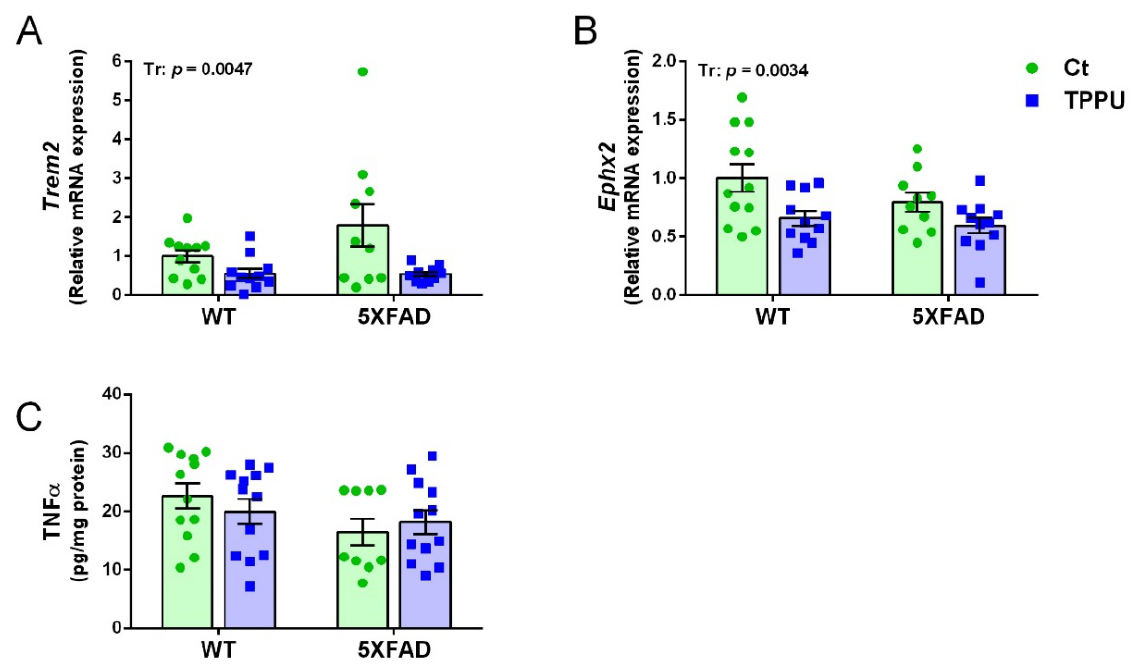
Figure 6. Neuroinflammatory markers in 2-month-old 5XFAD mice from litters with maternal TPPU treatment or control (Ct). Expression levels of the genes Trem2 ( A ) and Ephx2 ( B ); ( C ) tumor necrosis factor α (TNF α ) concentration (pg/mL). ( A , B ) Hippocampus samples; ( C ) cerebral cortex samples. Values are mean ± SEM (( A ) n = 10–11; ( B ) n = 10–12; ( C ) n = 9–12). Statistics: ANOVA, effect of treatment (Tr) in ( A , B ), p values of the significant factor are indicated in the corresponding graphs.